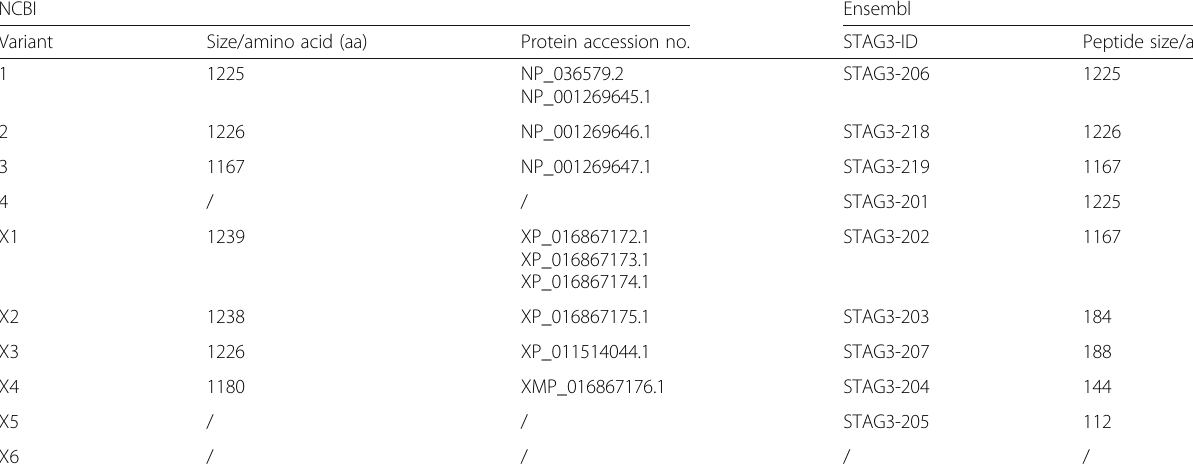
Table 1 The sizes and accession numbers of the STAG3 protein variants based on NCBI and Ensembl NCBI Ensembl Variant Size/amino acid (aa) Protein accession no. STAG3-ID Peptide